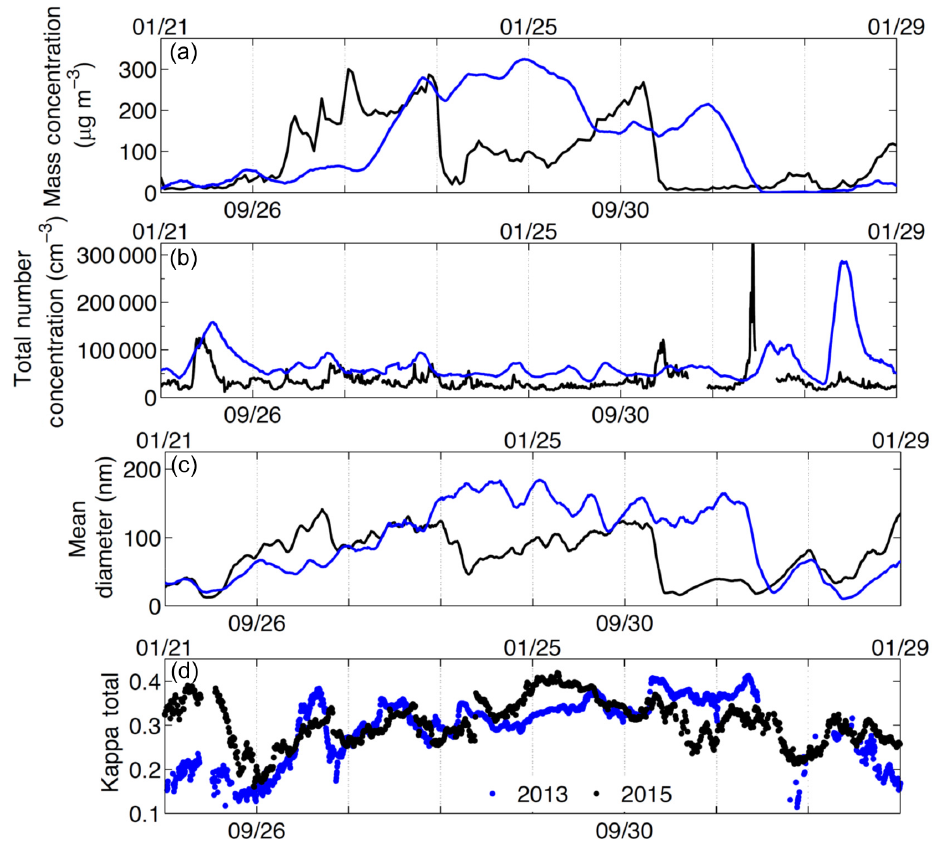
Figure 5. A comparison of the (a) mass concentration, (b) total number concentration, (c) average diameter, and (d) hygroscopicity between autumn 2013 (blue, bottom axis) and winter 2015 (black, top axis). Dates in this figure are given in the month/day format.